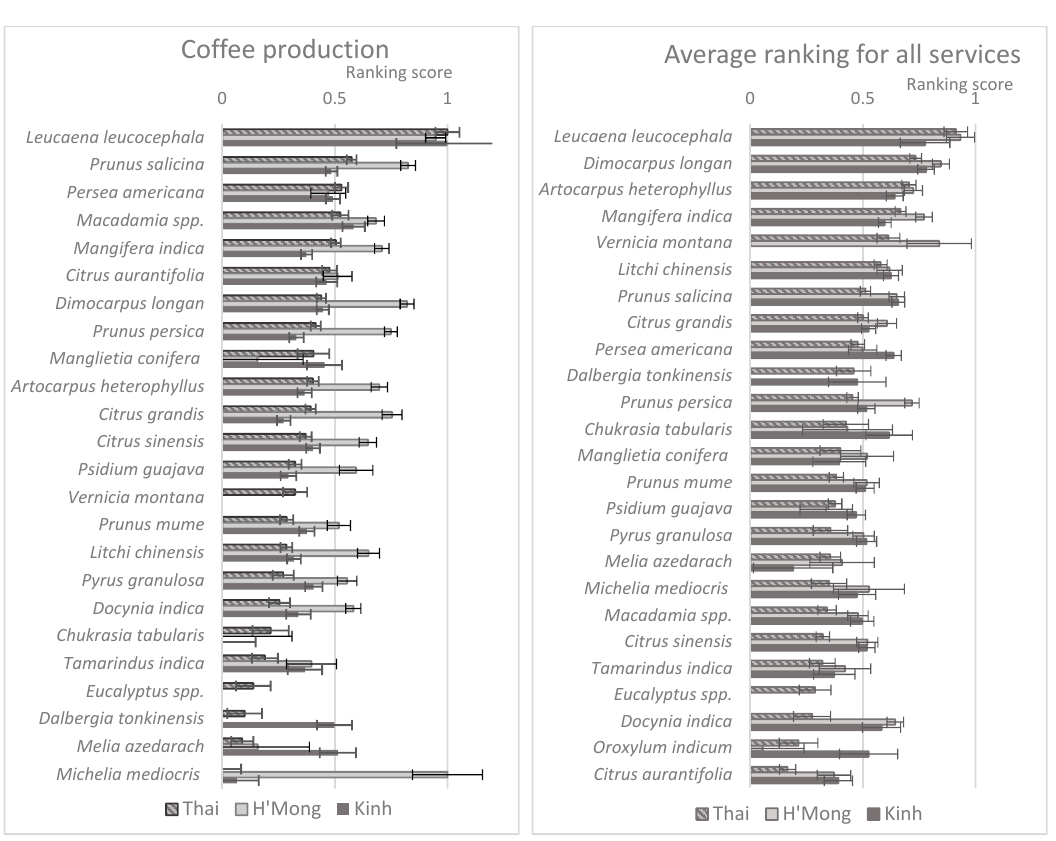
Figure A4. Pairwise ranking of tree species in coffee agroforestry systems by tree service and by ethnic group (Thai, H’Mong and Kinh).